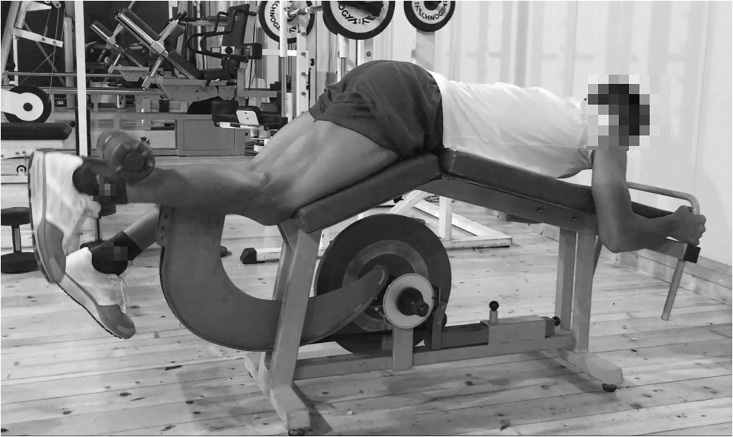
Flywheel leg-curl.